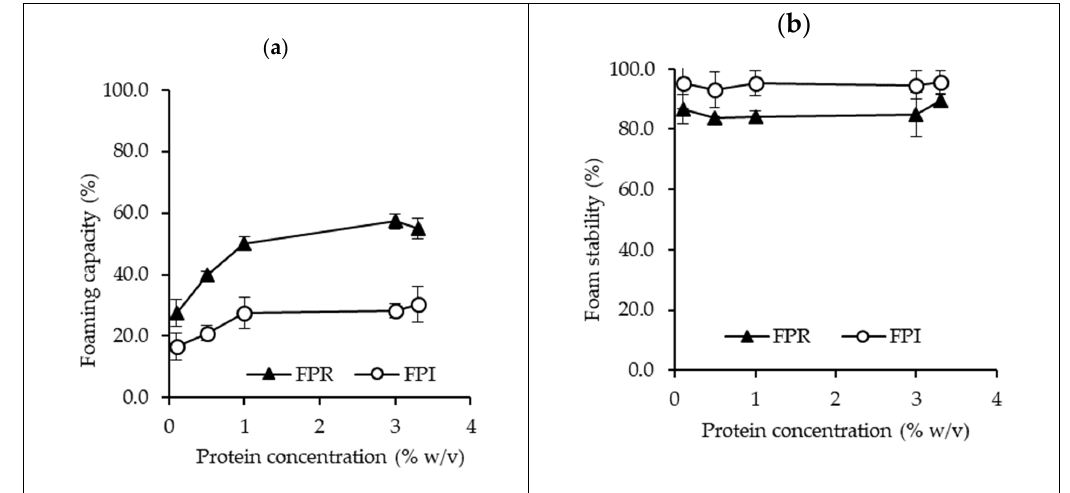
Figure 5. Foaming capacity ( a ) and foam stability ( b ) for FPR and FPI in the range of 0.1%–3.3% protein, at pH 7 and 22 °C (error bars show standard deviation).